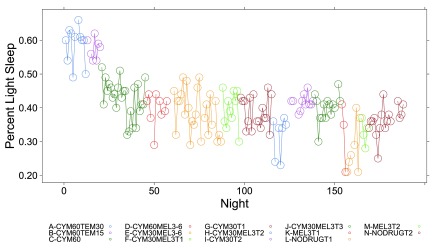
Percent light sleep per night.The percent time subject was in light sleep during 5-minute intervals detected by the Zeo Sleep Monitor throughout the entire study. Dosages of Cymbalta (CYM60 = 60 mg, CYM30 = 30 mg), temazepam (TEM30 = 30 mg, TEM15 = 15 mg) and melatonin (MEL3 = 3 mg, MEL6 = 6 mg) were varied according to combinations A-N (T1, T2, T3 are trial replicates), including no drug trials (L, N).